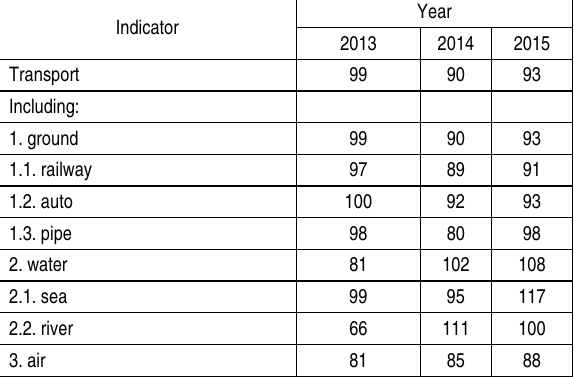
Table 4. Indicators of cargo volumes according to